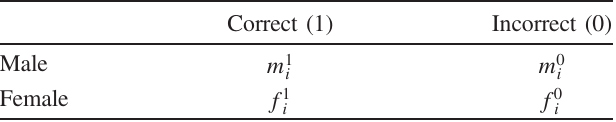
) and significance ( p ) values MH